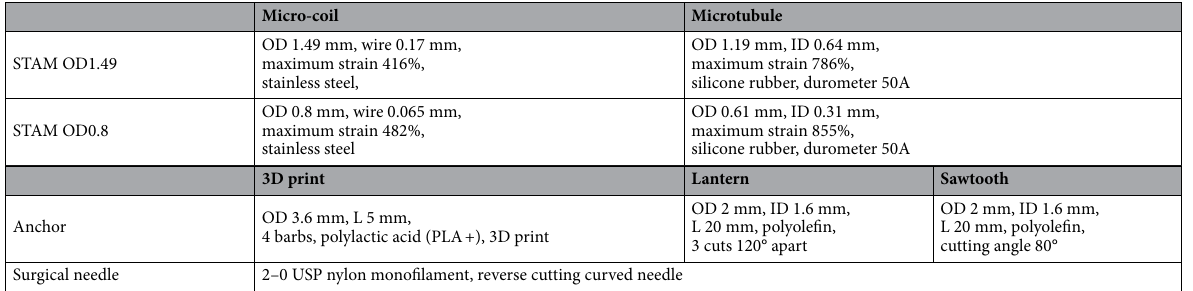
Table 1. Specifications of S 2 suture